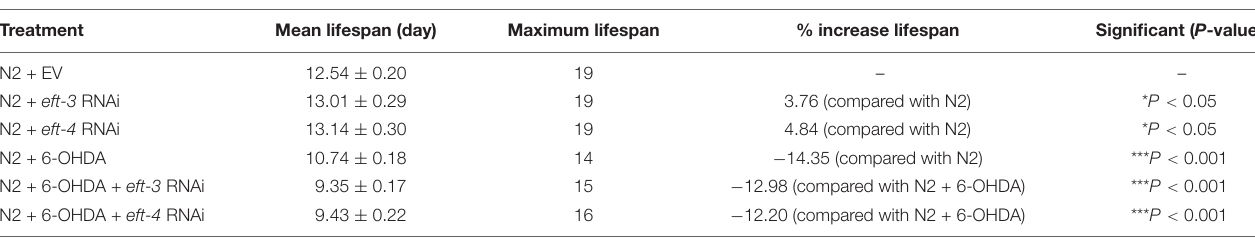
FIGURE 4 | Effects of eft-3 / eft-4 RNA interference (RNAi) and/or 6-hydroxydopamine (6-OHDA) exposure on lifespan in N2 Caenorhabditis elegans. Cumulative survival plots of 6-OHDA-treated (A) , co-treatment of eft-3/eft-4 RNAi and 6-OHDA-treated worms (B) , and empty vector (EV) RNAi-treated and eft-3 / eft-4 RNAi-treated worms (C) . Quantitative data representing mean lifespan, maximum lifespan, percentage of increased lifespan, and significance are shown in Table 2 . TABLE 2 | Mean lifespan, maximum lifespan, percentage of increase lifespan and significance P -